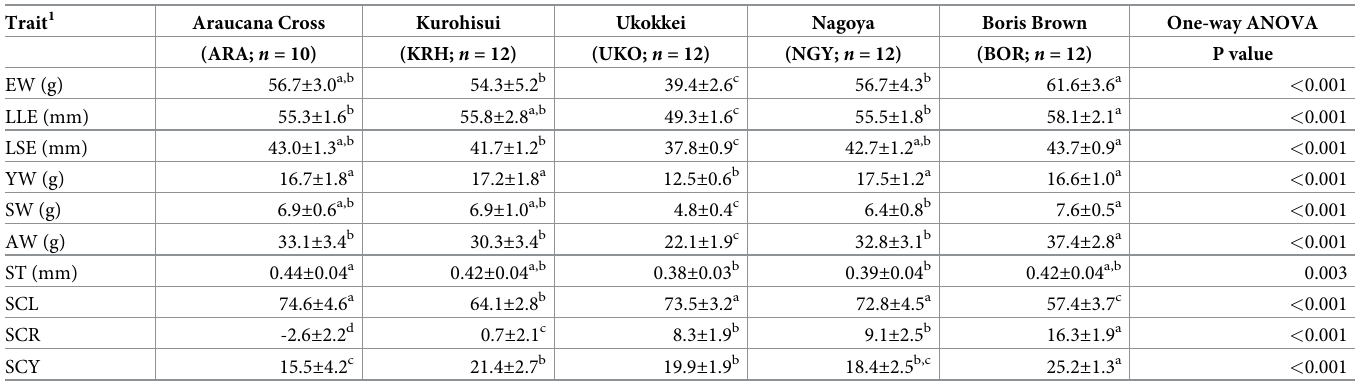
Table 1. Mean and standard deviation of 10 egg traits in five genotypes of chickens. Trait